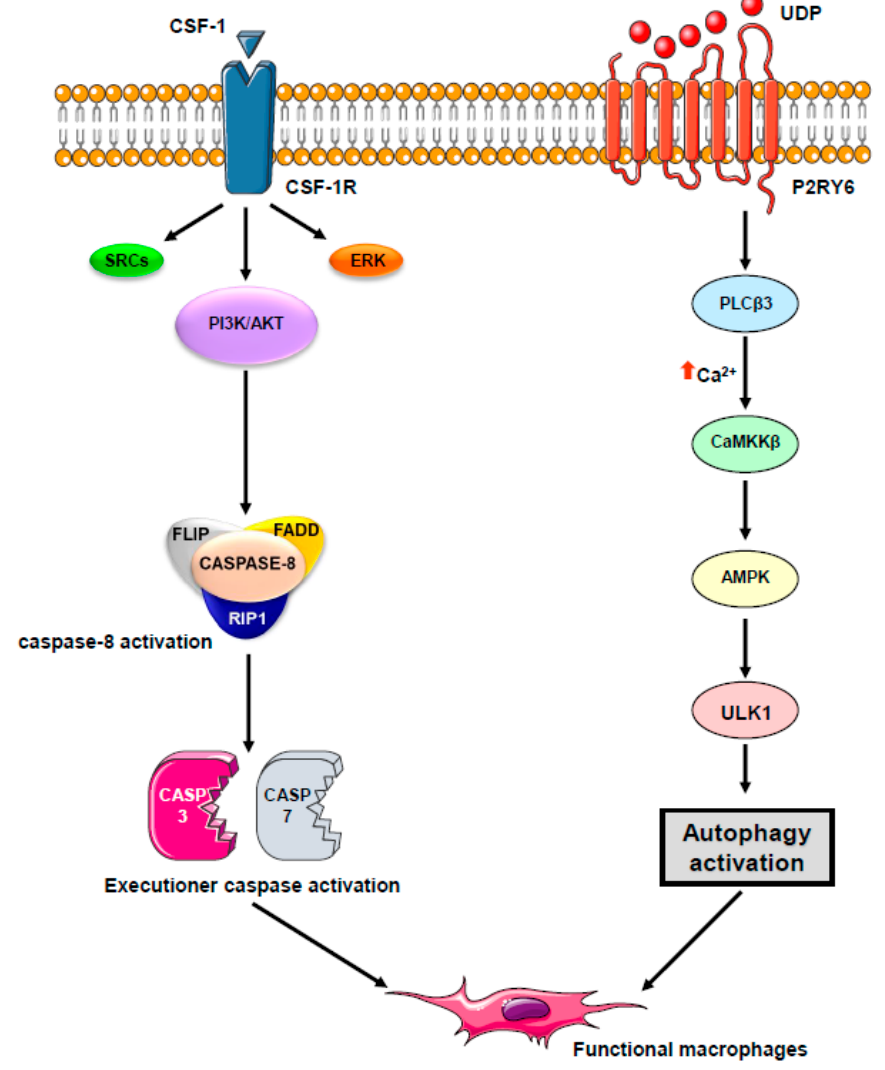
Figure 3. A schematic molecular view of the pathway involved in macrophagic differentiation. Engagement of the CSF-1 tyrosine kinase receptor by CSF-1 activates the PI3K/AKT pathway and induces caspase-8 activation within a FADD/RIP/FLIP multimolecular complex. In turn, active caspase-8 triggers a spatially restricted activation of caspase-3 and -7 that cleave selected intracellular proteins to generate a resting macrophage phenotype. Engaged CSF-1R also promotes autophagy through increasing the expression of the purinergic receptor P2RY6 that activates the CAMKK2-AMPK-ULK1 pathway. Caspase activation and autophagy induction are both required for proper generation of macrophages upon CSF-1 stimulation.